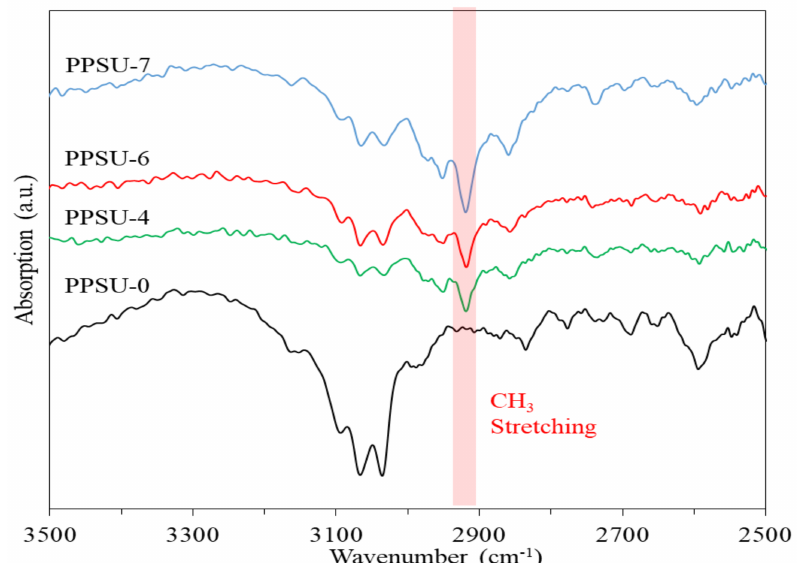
Figure 2. FTIR spectra of polymers.